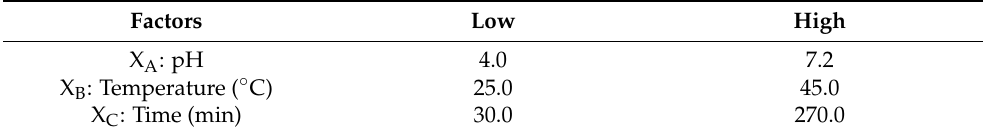
Table 1. Levels of factors evaluated on the hydrolysis process